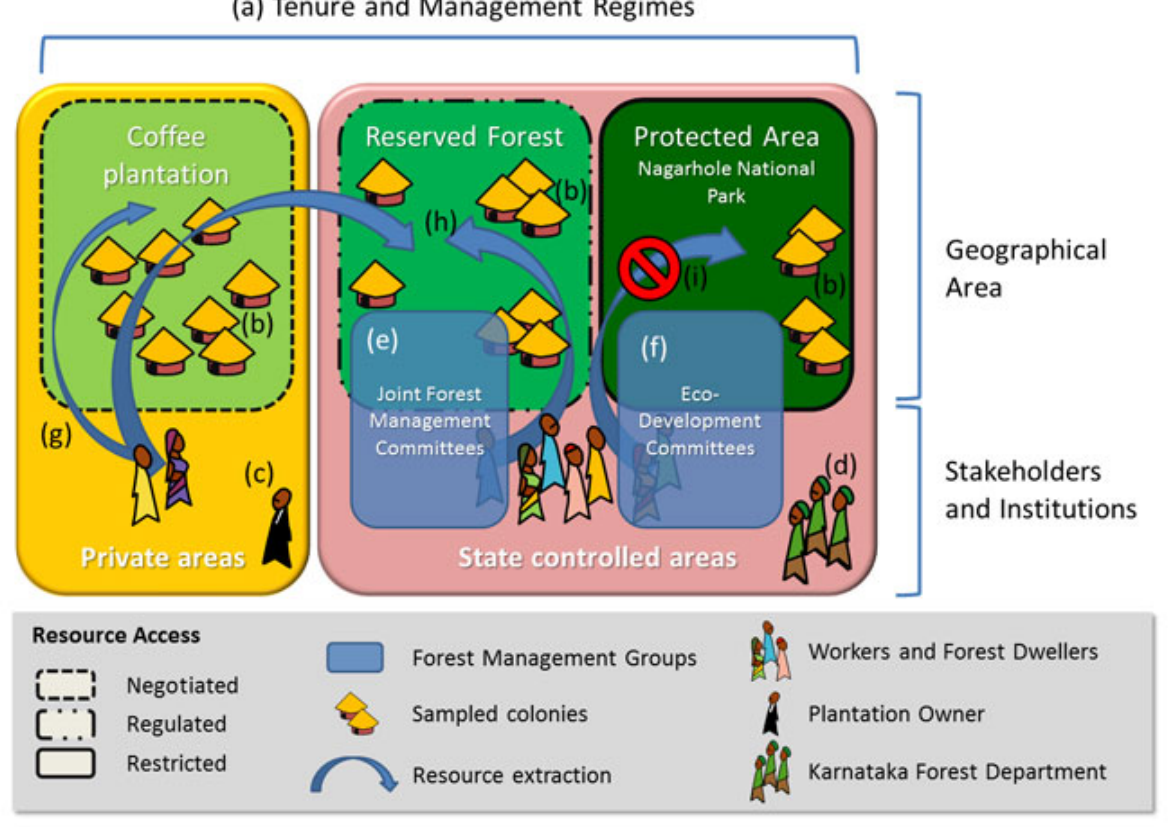
Fig. 2. Outline of the social-ecological system. We identified three tenure and management regimes (a) in the landscape: coffee plantations, reserved forests, and protected areas. In each of these three tenure and management regimes, workers and forest dwellers have their habitations, in small hamlets called colonies (b). Rights over the resources are controlled by the owner in the coffee plantation (c), and by the Karnataka Forest Department in the reserved forests and protected areas (d). Some of the workers and forest dwellers are part of forest management groups, called Joint Forest Management Committees (e) in reserved forests and Eco-Development Committees (f) in the protected area. For the workers, access to the resources, i.e., fuel wood, of the coffee plantation can be negotiated with the owner although persons not employed in the plantation are generally excluded (g). Access to the resources, i.e., fuel wood, nontimber forest products, is regulated in the reserve forest (h) and restricted (no legal access) in the national park (i). As a result, with the exception of the fuel wood for the workers, the reserved forest is the only accessible source of forest goods to the local